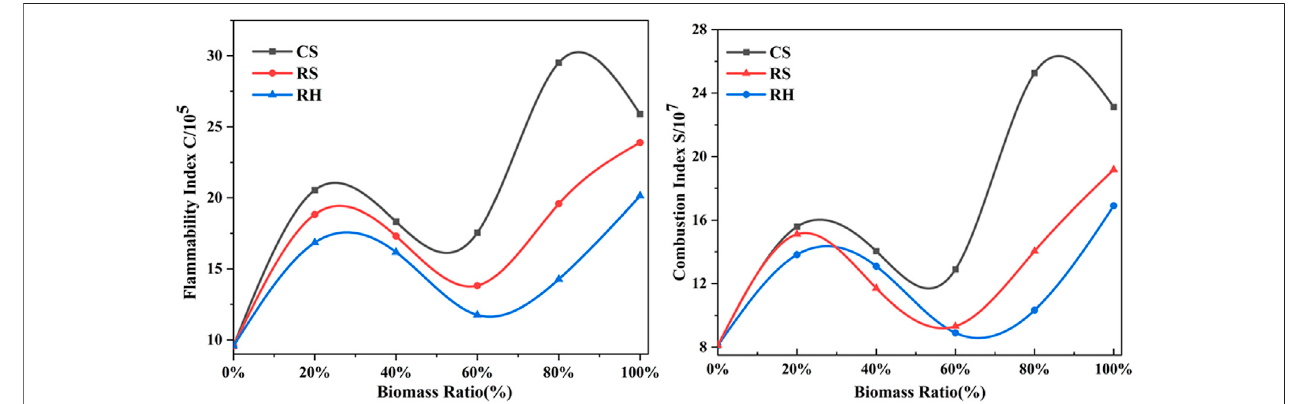
FIGURE 4 | C and S curves with increasing biomass